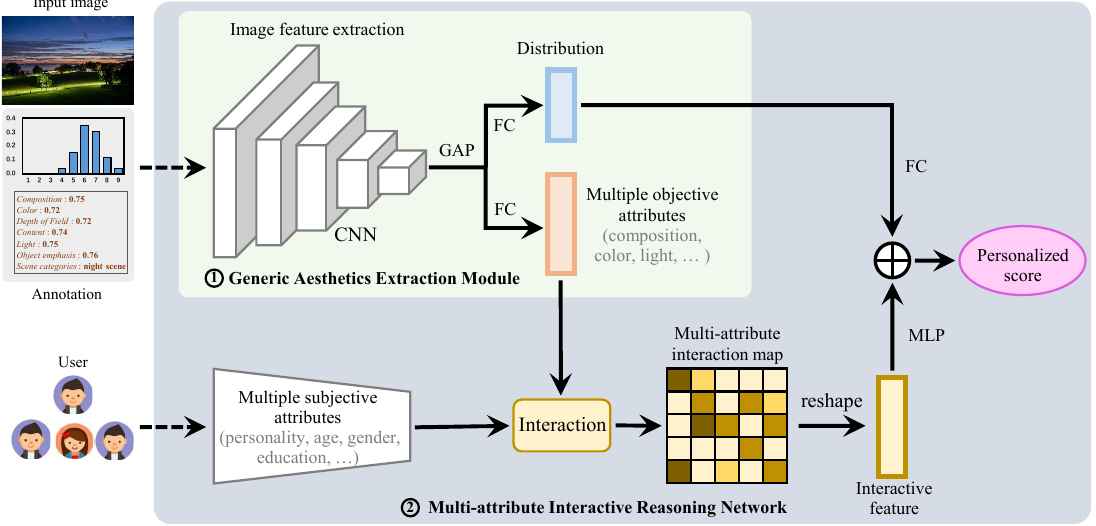
Figure 2. The overview architecture of our PIAA model, whose training process can be divided into three steps. In the first step, a generic aesthetics extraction module is used to simultaneously predict multiple attributes and aesthetic distributions from the perspective of images. In the second step, a multi-attribute interaction reasoning network is then introduced from the perspective of users to capture a multi-attribute interaction between users, as well as their rated images. Based on interactive features and the score distribution, a prior model is built to fuse them for obtaining personalized aesthetic scores. In the third step, the PIAA model of an individual user can be obtained by fine-tuning the user’s personalized